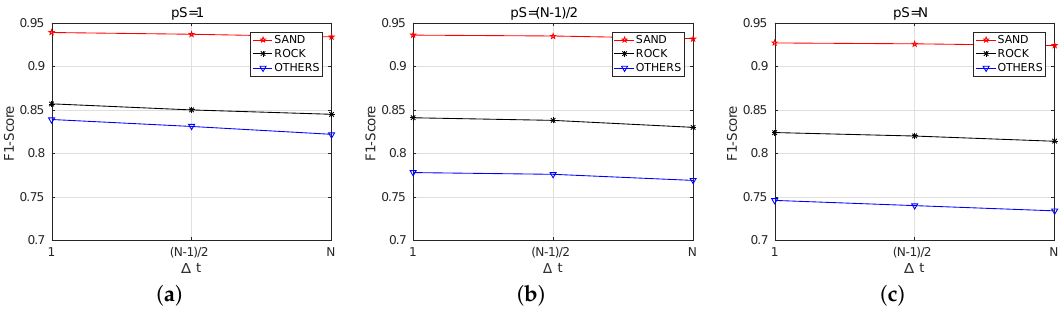
Figure 13. F1-Scores for MCM training with ( a ) pS = 1, ( b ) pS = N − 1